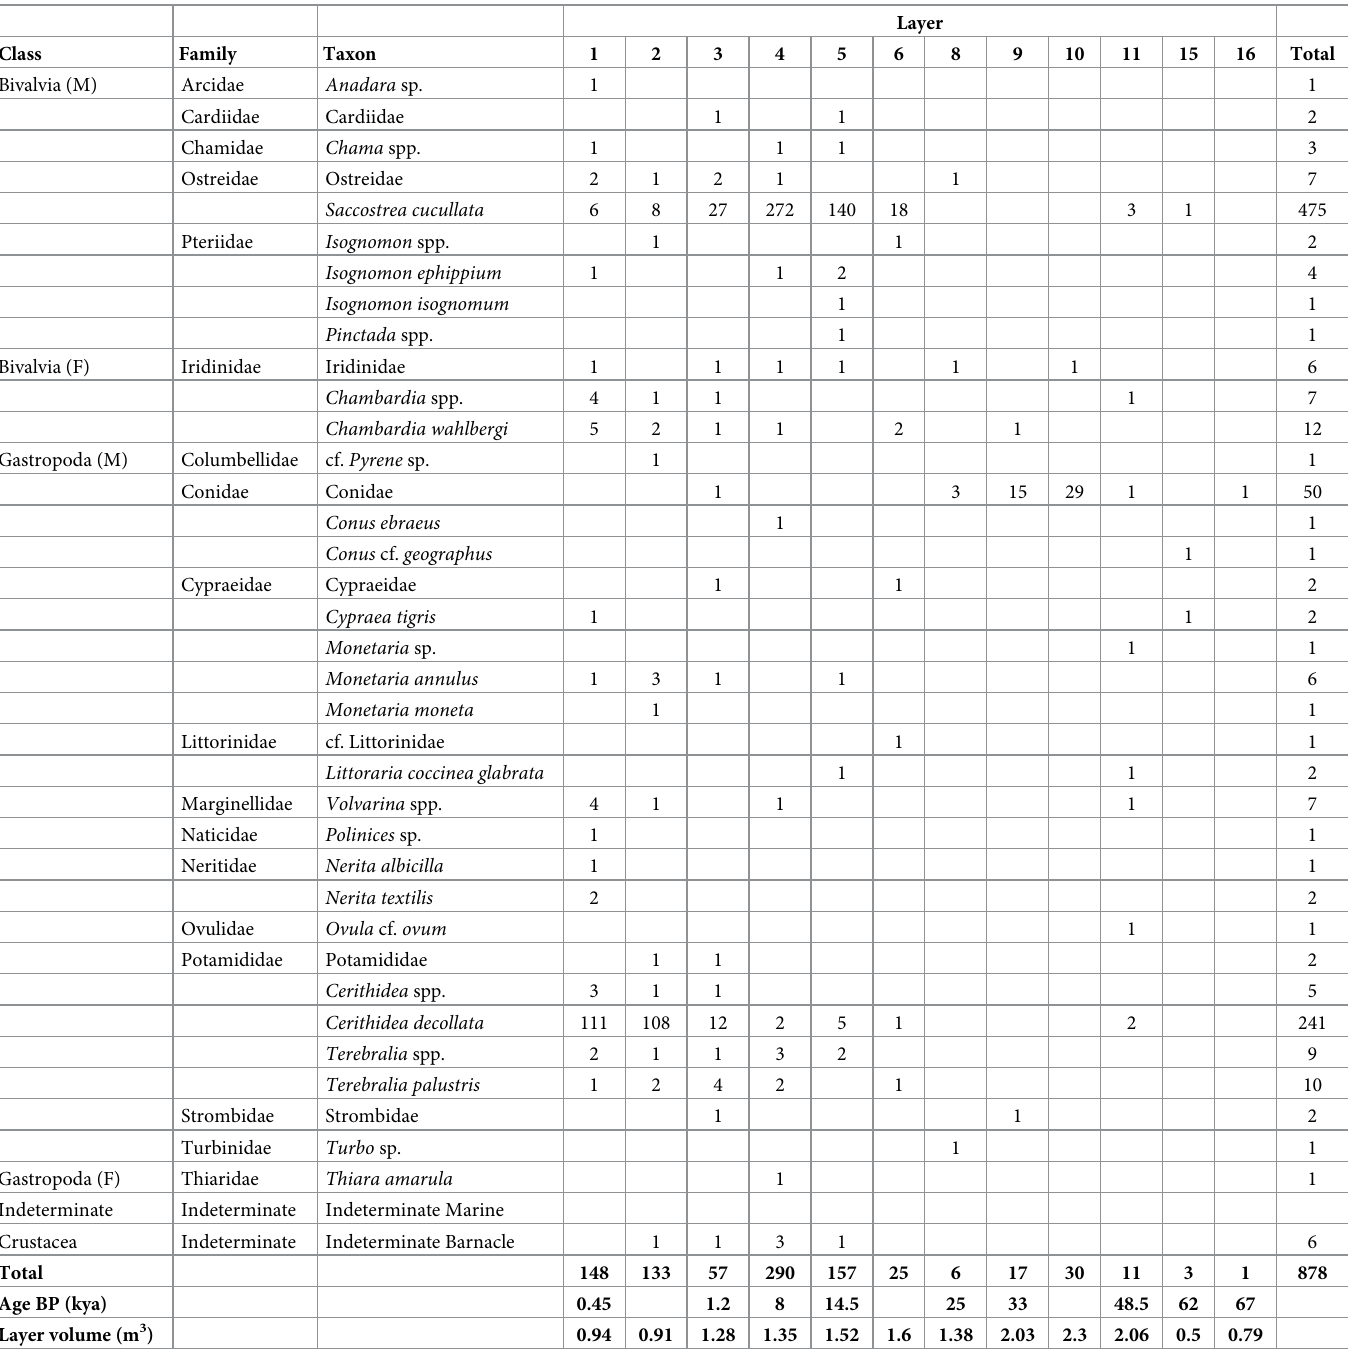
Table 2. PYS invertebrate MNI by